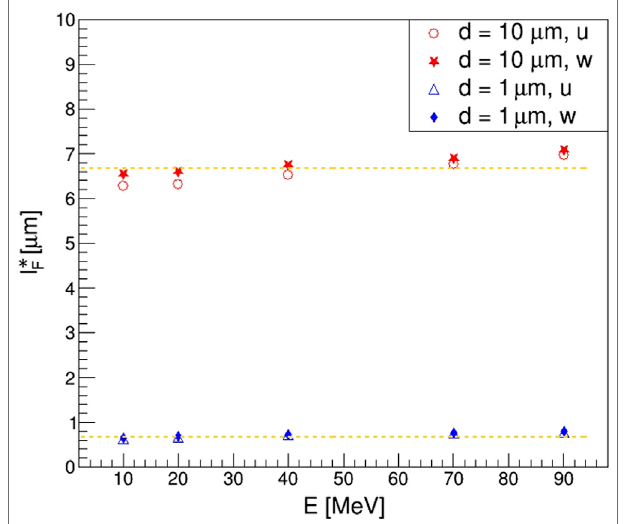
FIGURE 11 | Effective mean chord length (cid:1) l * F as a function of the proton energy obtained with uniform (open markers) and weighted (full markers) random sampling for sites of 1 μ m (blue triangles and diamonds) and 10 μ m (red circles and stars) diameter. The “ geometrical ” mean chord lengths (cid:1) l (cid:2) 2 d /3 are reported for comparison as yellow horizontal dashed lines. F